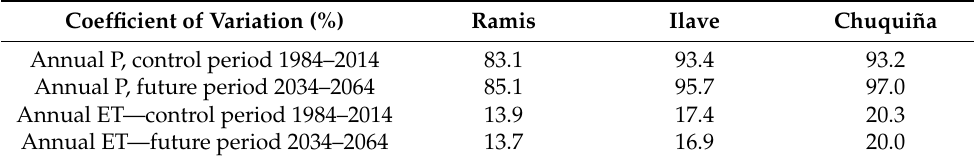
Table 4. Coefficient of annual variation (%) for the control period (1984–2014) and future period (2034–2064), for the basins controlled at the Ramis, Ilave (Peru), and Chuquiña (Bolivia) stations. Coefficient of Variation (%) Ramis